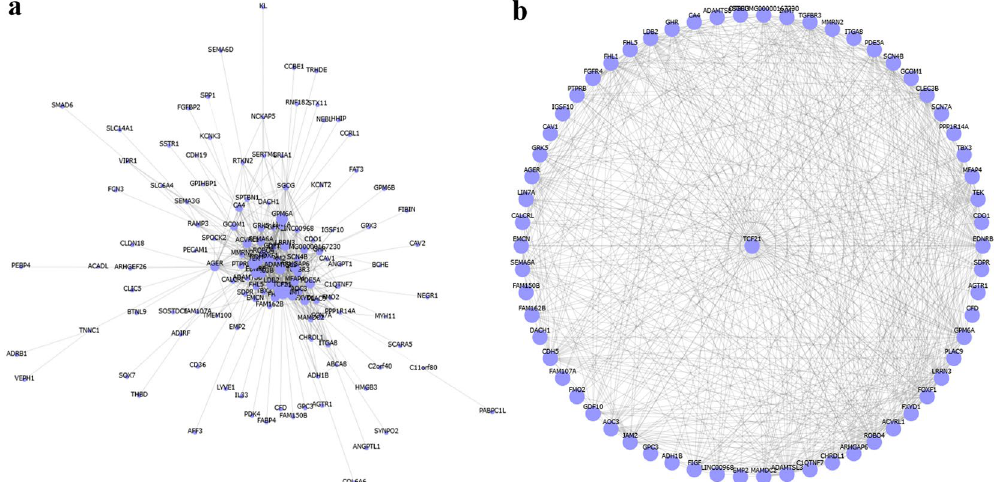
Figure 3. Gene co-expression network of the DEGs that eliminated gender differences for GSE40791. ( a ) The gene co-expression network. ( b ) Sub-graph shows that TCF21 has the most gene connections in the gene co- expression network.